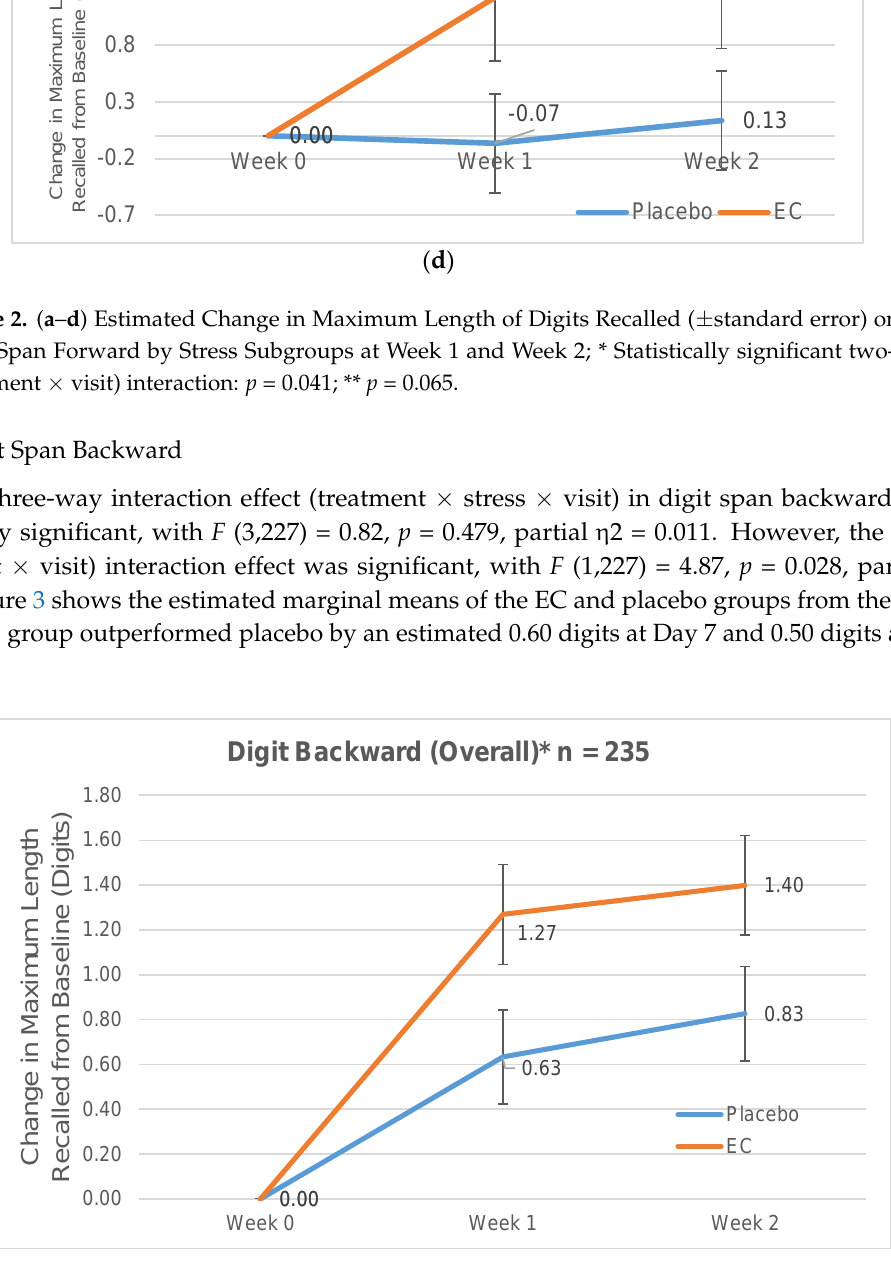
Figure 3. Estimated Change in Maximum Length of Digits Recalled (±standard error) on the Digit Span Backward at Weeks 1 and 2; * Statistically significant two-way (treatment × visit) interaction: p = 0.028.